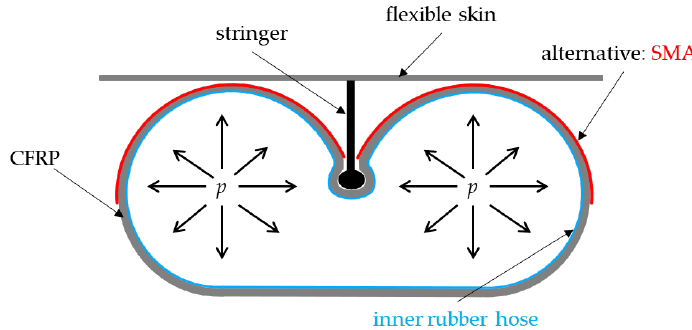
Figure 8. Tube Spring actuator made out of carbon fiber reinforced polymer (CFRP) that can be activated via pressure ( p ) or a shape memory alloy (SMA) based on [49,74].